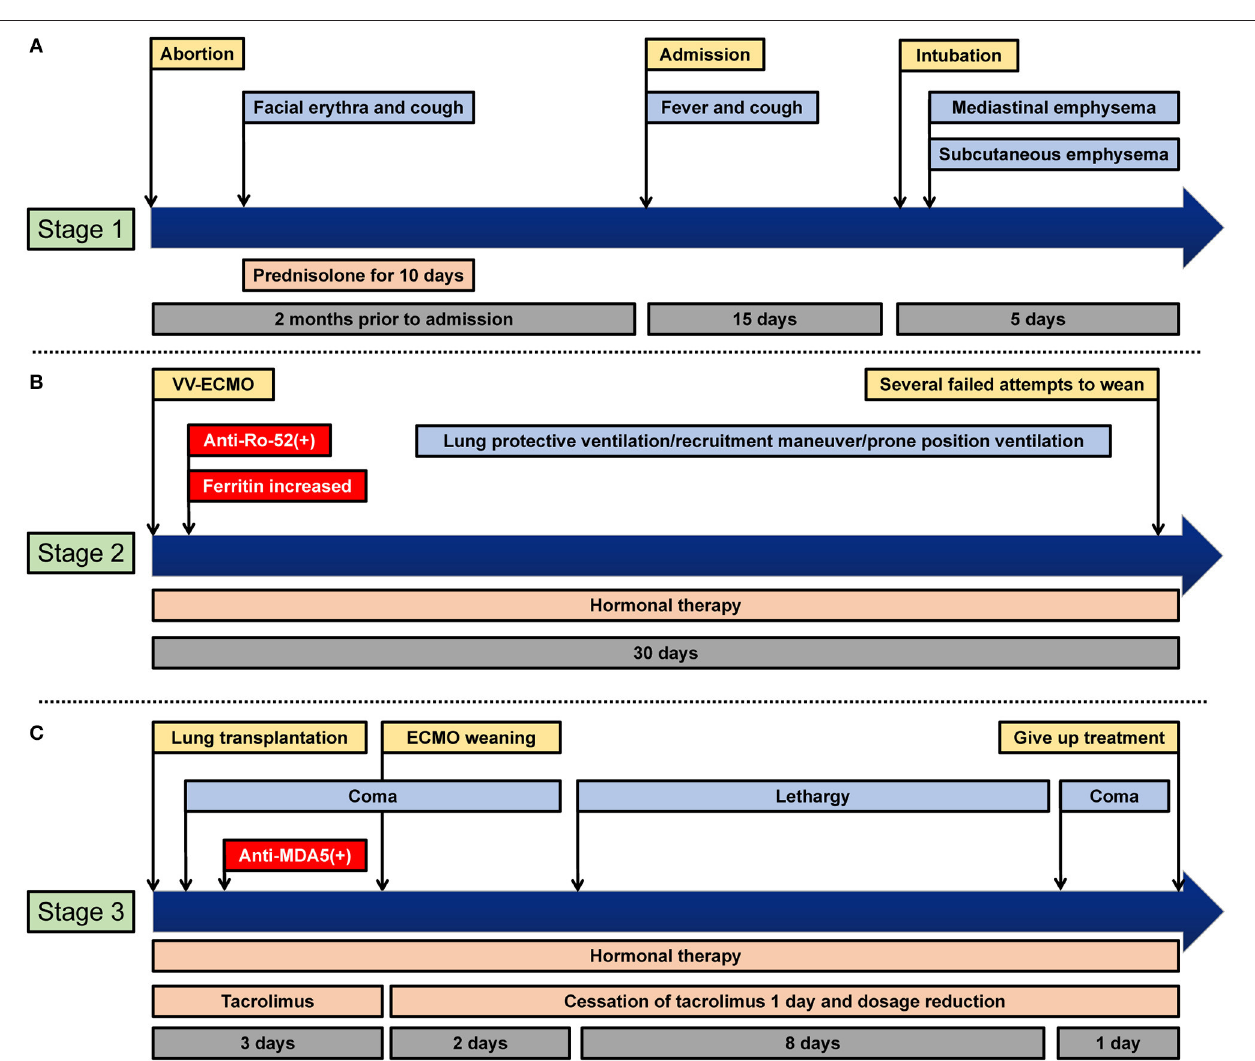
FIGURE 1 | Clinical course of the patient. (A) Stage 1: from pathogeny to intubation. (B) Stage 2: ECMO stage. (C) Stage 3: transplant and post-transplant